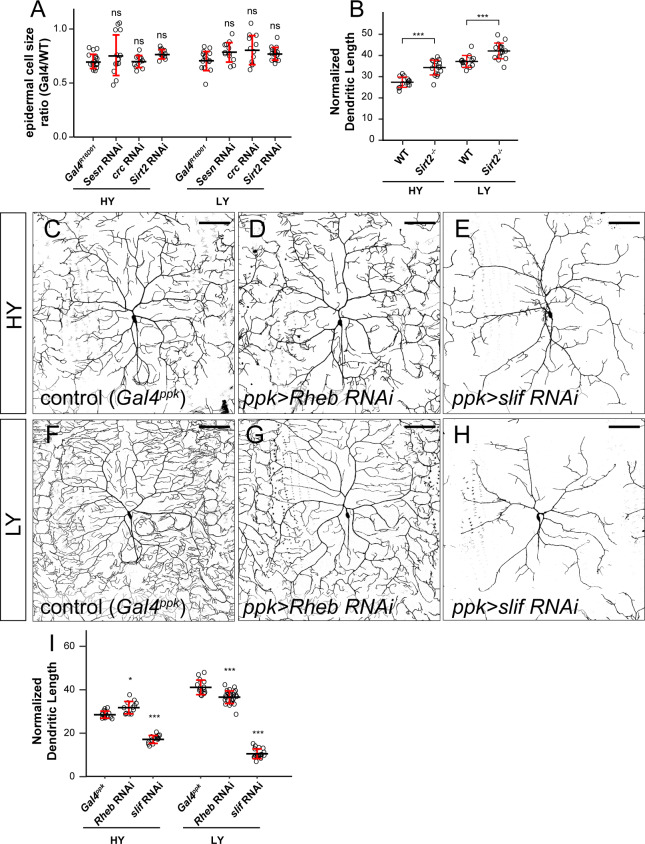
The effects of LOF of Sesn, crc, Sirt2, Rheb, and slif on C4da dendrite growth.(A) Quantification of epidermal cell size ratio (Gal4R16D01 cells/WT cells) in HY and LY conditions for genotypes indicated. Two-way ANOVA, Posthoc contrasts with a Dunnett correction. The differences between control and sesn RNAi under HY and LY conditions are not significantly different as indicated by a non-significant interaction term (p=0.1674), the same for crc RNAi (p=0.0777) and sirt2 RNAi (p=0.0597). Each circle represents a segment; HY: n = 18 for control, n = 14 for Sesn RNAi, n = 12 for crc RNAi, n = 11 for Sirt2 RNAi; LY: n = 16 for control, n = 12 for Sesn RNAi, n = 12 for crc RNAi, n = 16 for Sirt2 RNAi. (B) Quantification of normalized dendritic length in HY and LY conditions for WT animals and Sirt2 mutants. Two-way ANOVA. The differences between control and sirt2 mutants are not significantly different between the HY and LY, as indicated by a non-significant interaction term (p value=0.2471). Each circle represents a neuron; n = 13 for control, n = 18 for Sirt2 mutant in both conditions. (C–H) ddaC neurons in the Gal4ppk control (C and F) and animals expressing Gal4ppk-driven Rheb RNAi (D and G) and slif RNAi (E and H) in HY and LY conditions. (C) and (F) are the same as Figure 2A and D, respectively. (I) Quantification of normalized dendritic length in control, Rheb RNAi and slif RNAi animals in HY and LY conditions. Two-way ANOVA, Posthoc contrasts with a Dunnett correction. The differences between control and Rheb RNAi under HY and LY conditions are significantly different as indicated by a significant interaction term (p=8.37e-08), the same for slif RNAi (p=2e-16). Each circle represents a neuron; HY: n = 14 for Gal4ppk, n = 12 for Rheb RNAi, n = 14 for slif RNAi; LY: n = 14 for Gal4ppk, n = 26 for Rheb RNAi, n = 17 for slif RNAi. Gal4ppk is the same dataset as in Figure 2G. ***p<0.001. Significance level is for comparison between the control and the genotype indicated under the same food condition in (A) and (I). Black bars, mean; red bars, SD. Scale bars, 100 μm in (C–H).